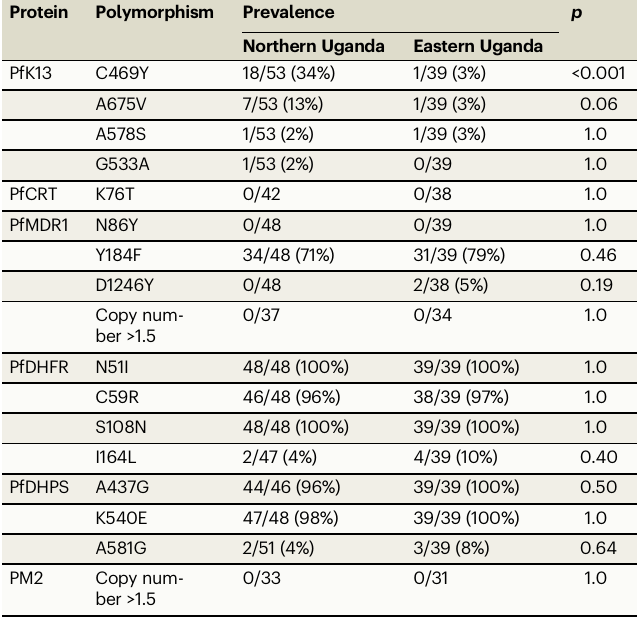
Table 2 | Genetic polymorphisms in P. falciparum isolates from northern and eastern